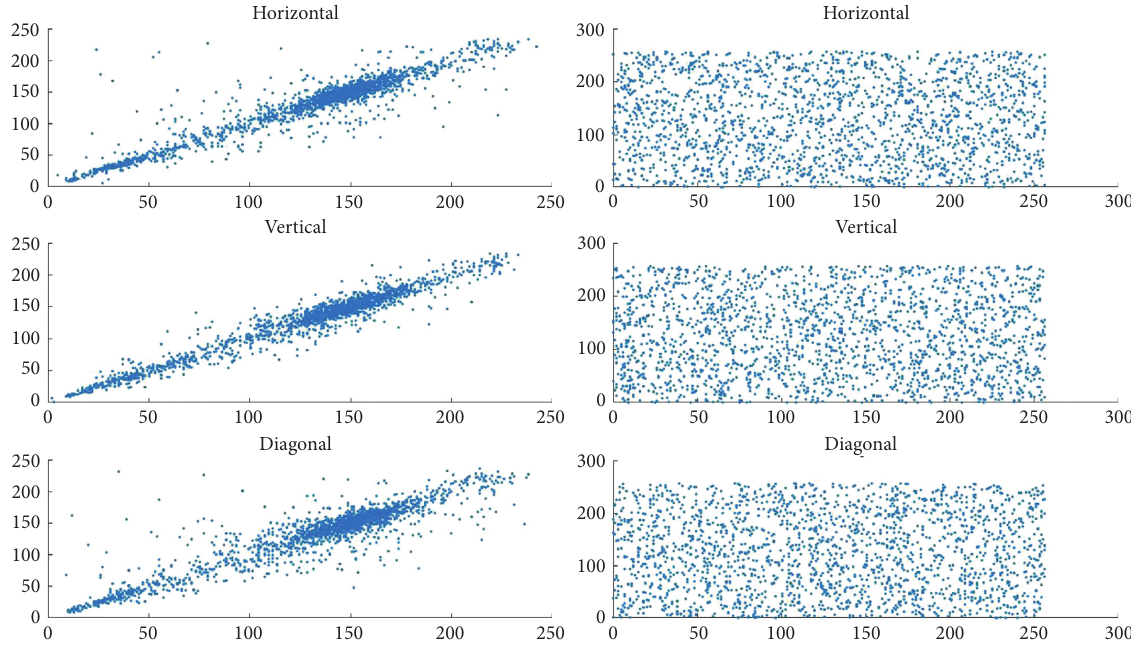
Figure 11: Adjacent pixel correlation test for plain grayscale “Boat” image (a) and the corresponding encrypted image (b) for horizontal, vertical, and diagonal directions.